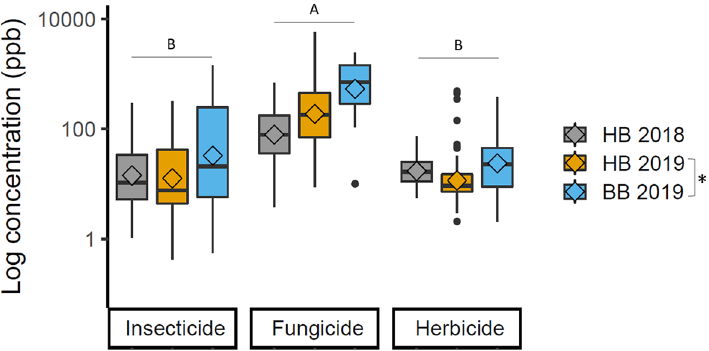
Figure 2. Concentrations of pesticides detected in bee-collected pollen from colonies. Each data point represents the concentration of an active ingredient found in an individual sample. Pesticides were detected in pollen collected from honey bees in 2018 (grey), pollen collected from honey bees in 2019 (yellow), and pollen collected from bumble bees in 2019 (blue). Dark lines indicate the median, diamonds indicate the mean, boxes represent the upper and lower quartile, whiskers indicate the maximum and minimum concentration detected (besides outliers), and the dots represent outliers. Letters indicate significant differences between the pesticide types and this pattern was consistent when all samples were combined for analyses, or when samples were separated out by bee and year for analyses. Graph created in R 30 v3.6.2 with the package ggplot2 43